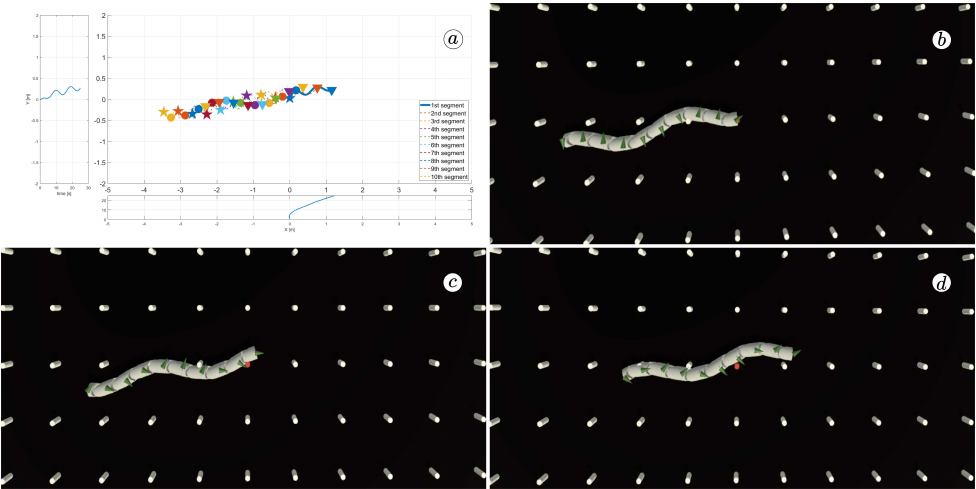
Figure 21. Trajectories of robot segments for φ i ,ref = 30 ◦ sin ( 40 ◦ t + ( i − 1 ) 60 ◦ ) ( a ) and robot configu- rations for t = 5 ( s ) ( b ), t = 10 ( s ) ( c ), and t = 24 ( s ) ( d